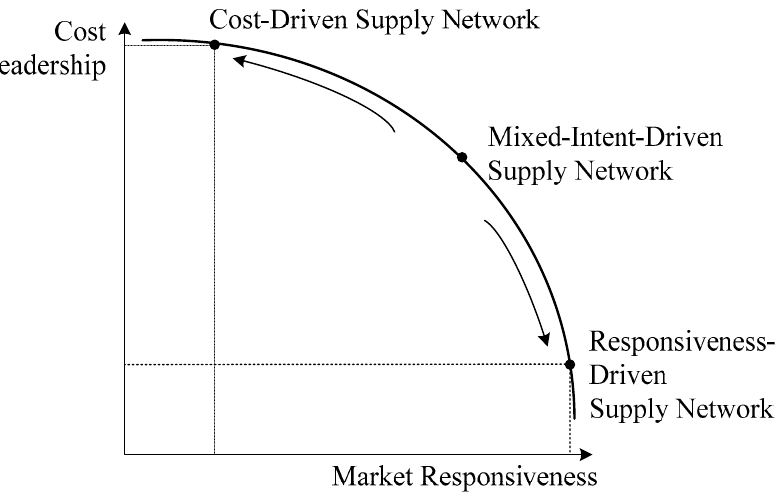
Figure 1. Strategic intents and corresponding supply network types.